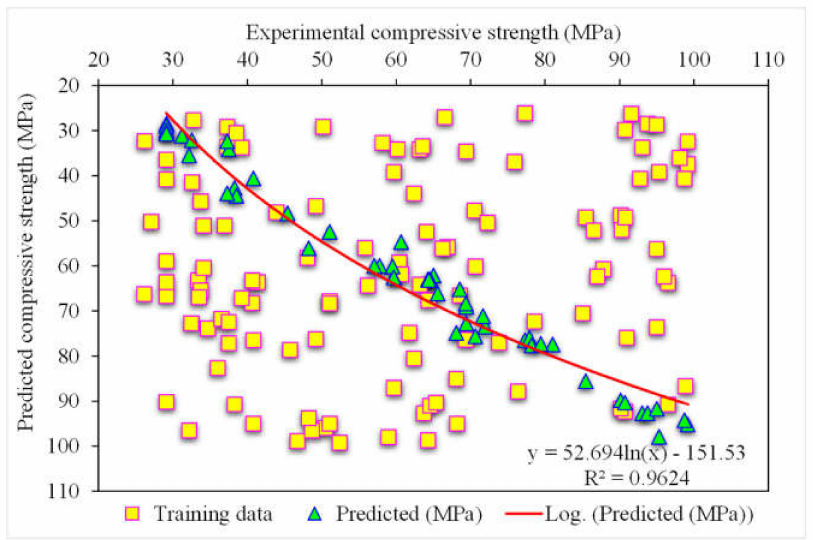
Figure 11. Experimental and random forest predicted